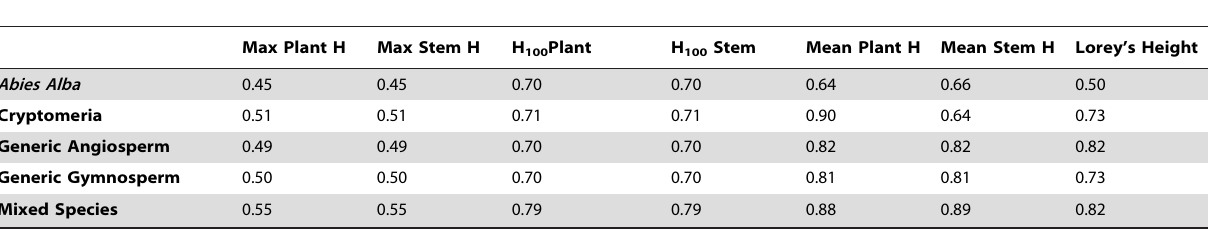
Table 3. r 2 values comparing best fitting curve of height classes to forest volume associated with each individual forest composition data set with default